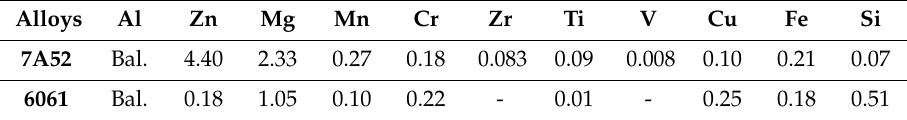
Table 1. Chemical composition of 7A52 and 6061 aluminum